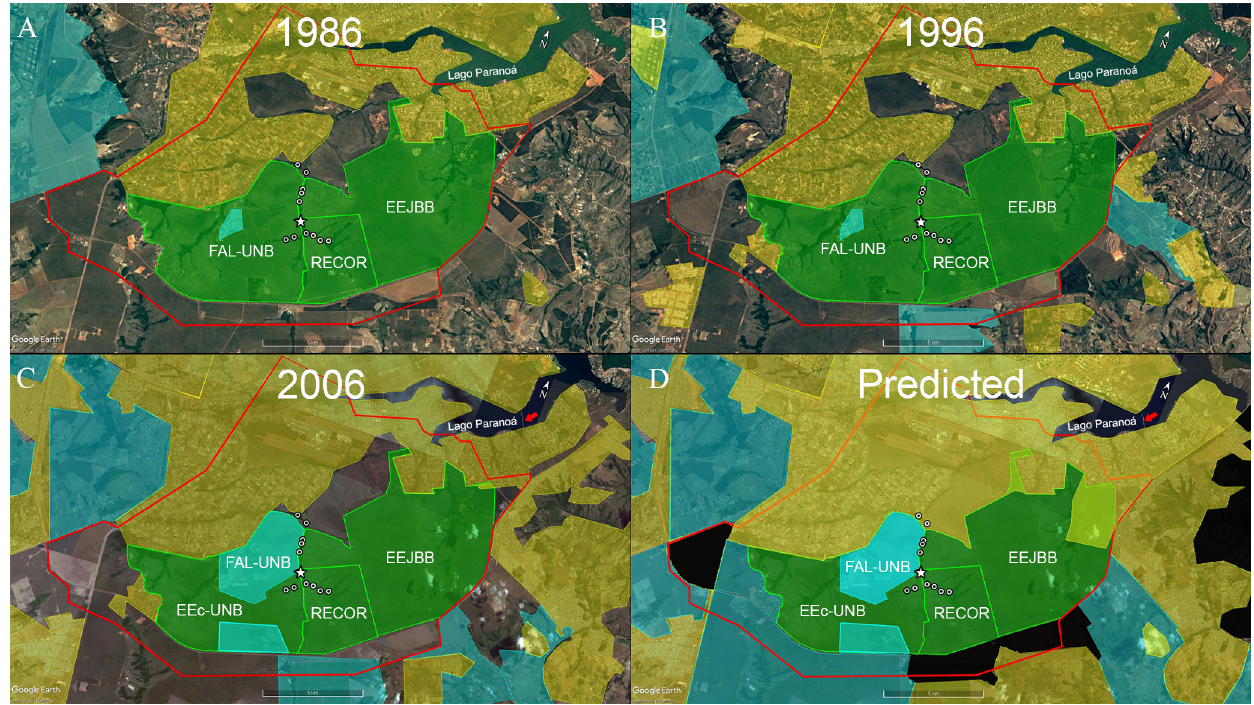
FIGURE 7 | Satellite images of the Area de Preservação Ambiental das Bacias do Gama e Cabeça de Veado (highlighted in red), showing the land use and cover changes along the past 34 years, and predicted: in A . year of 1986, with urban areas concentrated north of the FAL–UNB, RECOR and EEJBB; B . year of 1996, illustrating the beginning of expansion of urban and rural areas just east of the FAL–UNB, RECOR and EEJBB; C . year of 2006, after the construction of the Juscelino Kubitschek bridge in 2002, illustrating a rapid expansion of urban areas in the eastern area; and D ., predicted situation according to the Distrito Federal Territorial Planning Master Plan (2009, 2019). Green polygons indicate protected areas; yellow, urban areas; blue, rural areas; black, public land; and, red arrow, the Juscelino Kubitschek bridge. Abbreviations: FAL–UNB, Estação Experimental Fazenda Águas Limpas of the University of Brasília; RECOR, Reserva Ecológica do